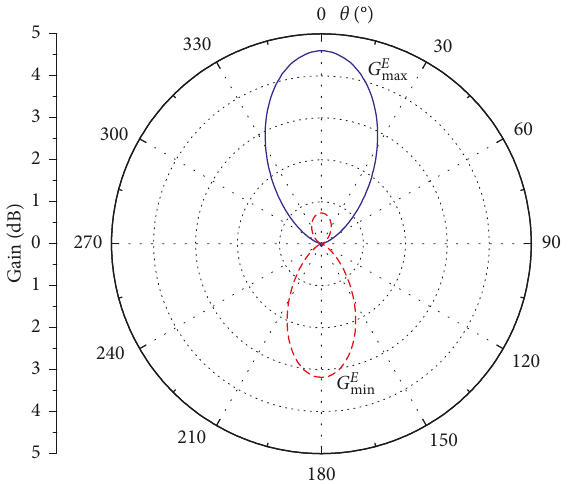
Figure 6: Gain patterns of the V-array with maximum and minimum radiation